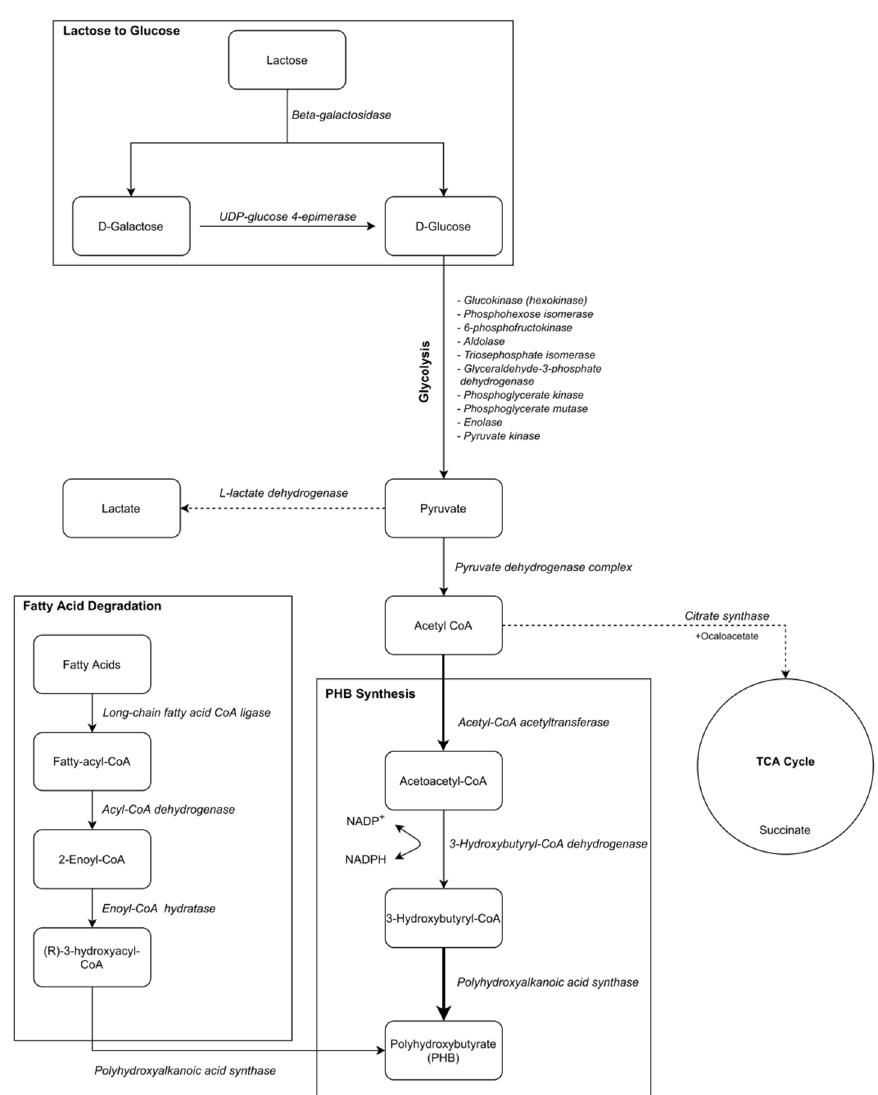
Figure 6. Scheme for PHB synthesis pathway including responsible enzymes based on RAST server annotations of B. marmarensis genome (continuous line arrows: paths for PHB synthesis; dotted line arrows: paths that cause decrease in PHB synthesis). Table 2. The annotated B. marmarensis enzymes and their target substrates in the PHB synthesis pathway.